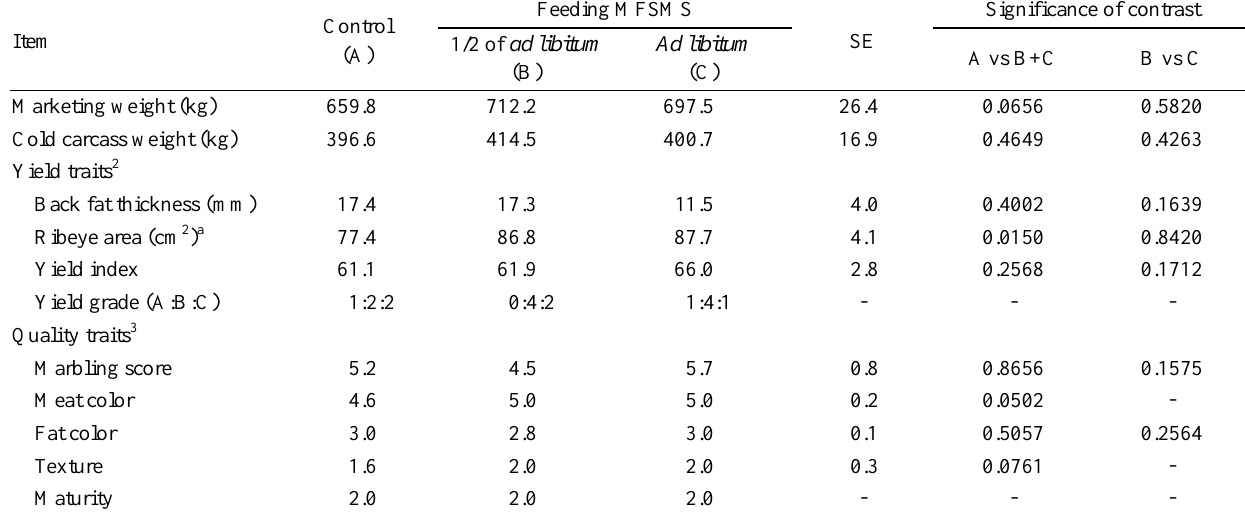
Table 5. Carcass characteristics of Hanwoo steers supplemented with microbially-fermented spent mushroom substrates (MFSMS) 1 Feeding Control Item